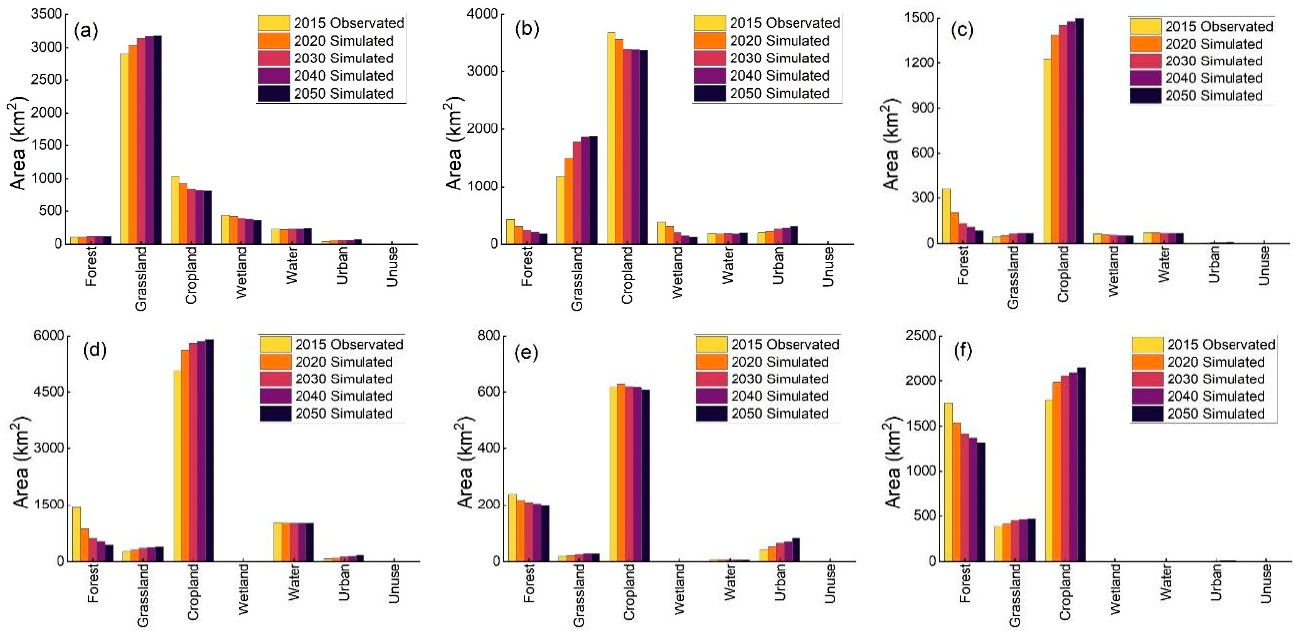
Figure A1. Map of the six agro-ecological zones [53].